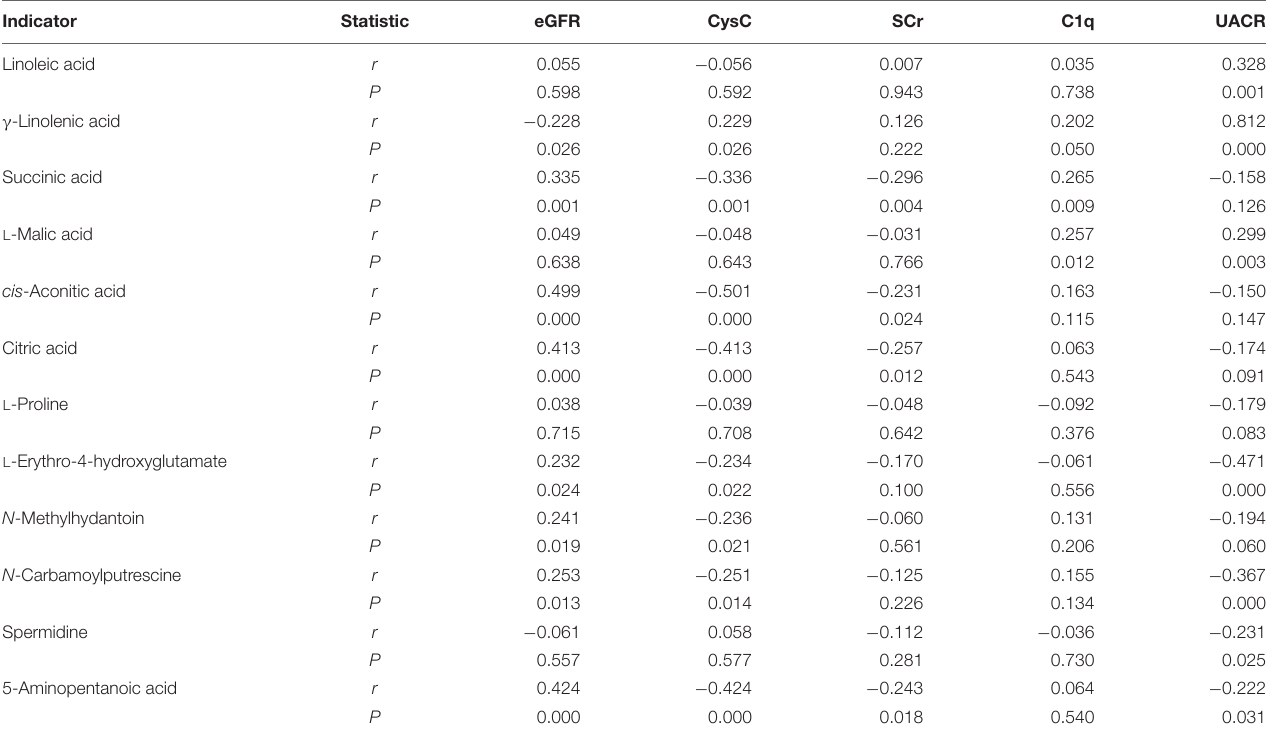
TABLE 3 | Correlation analysis of differential metabolites and kidney function